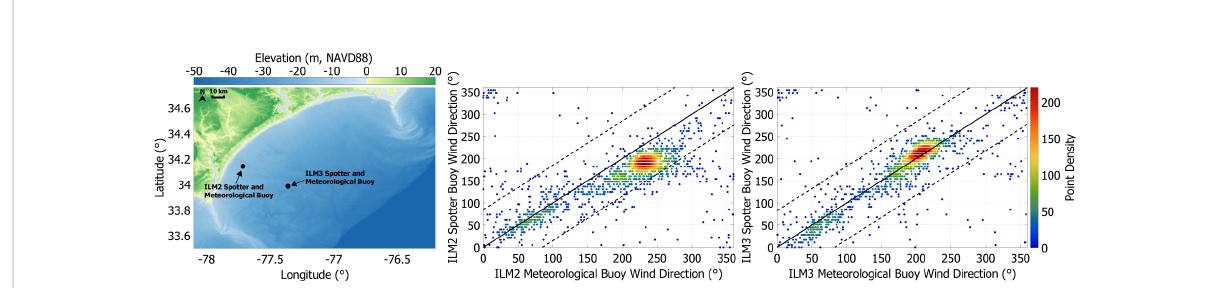
FIGURE 12 Locations of the two Spotter buoys and associated meteorological buoys (left), and density scatter plots comparing Spotter buoy derived wind directions to wind directions recorded by the nearest meteorological buoy. The solid black line through the origins shows a 1:1 relationship between each compared buoy; the dashed black lines show one standard deviation for the meteorological buoys from the 1:1